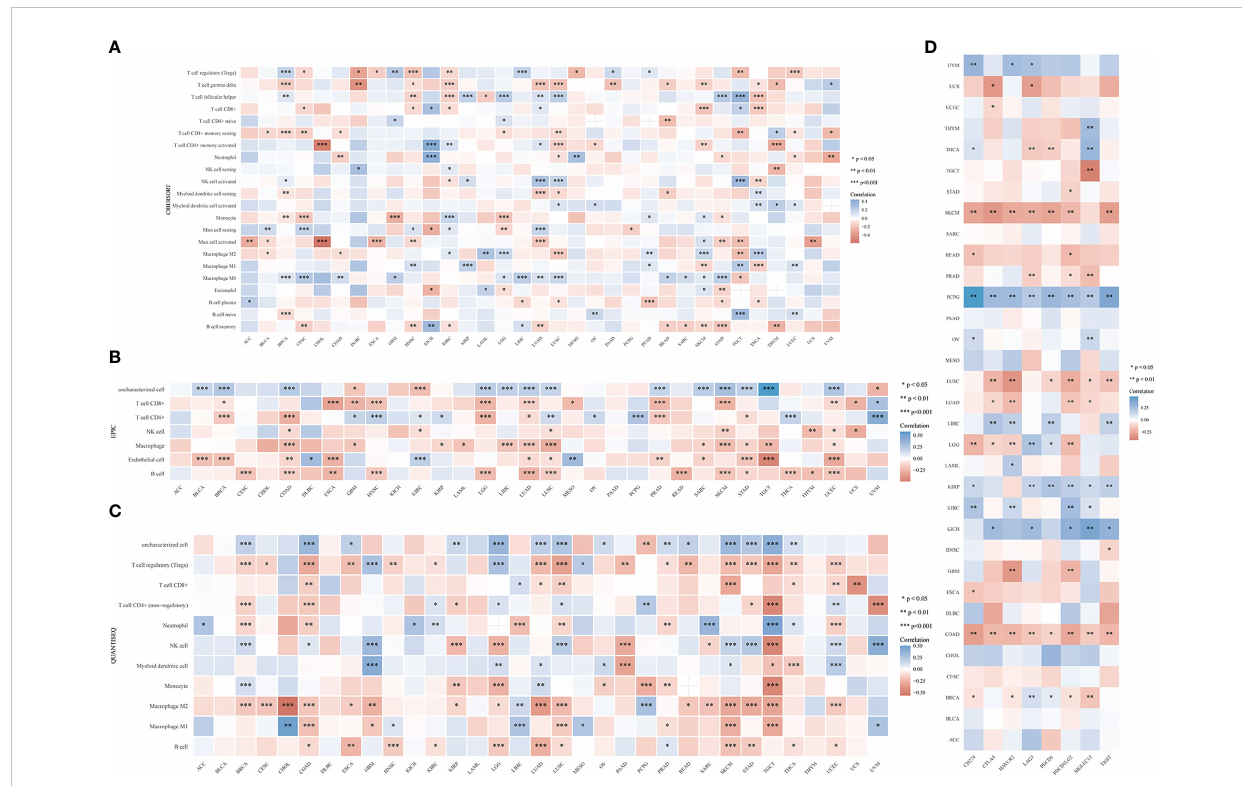
FIGURE 13 RRS1 expression in relation to immune cell in fi ltration or immune-checkpoint genes analyzed via pan-cancer analysis. (A) Correlation between RRS1 expression and in fi ltration levels of various immune cells based on CIBERSORT. (B) Correlation between the RRS1 expression and in fi ltration levels of